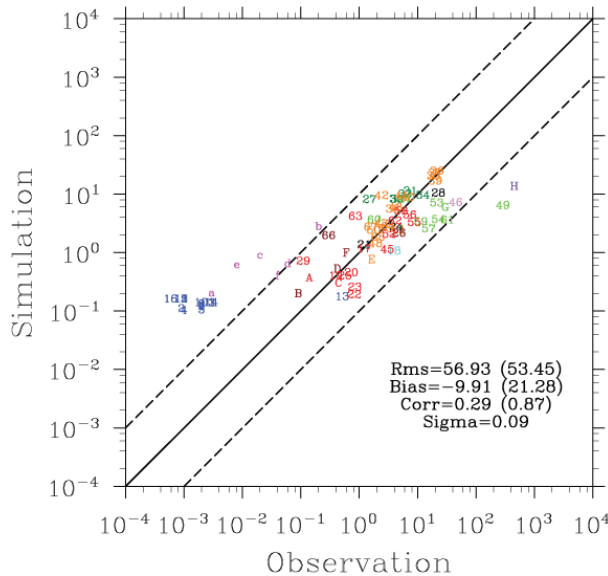
Fig. 13. Comparison between modelled and compiled data of dust deposition rates (gm − 2 yr − 1 ). Stations are grouped regionally as shown in Fig. 12. Root mean square error (Rms), bias, correlation (Corr) and ratio of modelled to observed standard deviation (sigma) are indicated. Normalized root mean square error and mean nor- malized bias are given in the parenthesis next to Rms and Bias. The correlation with respect to the logarithm of the model results and of the observation is given in the parenthesis next to Corr. Black solid line is the 1 : 1 line and black dash lines are 10 : 1 and 1 : 10 lines.